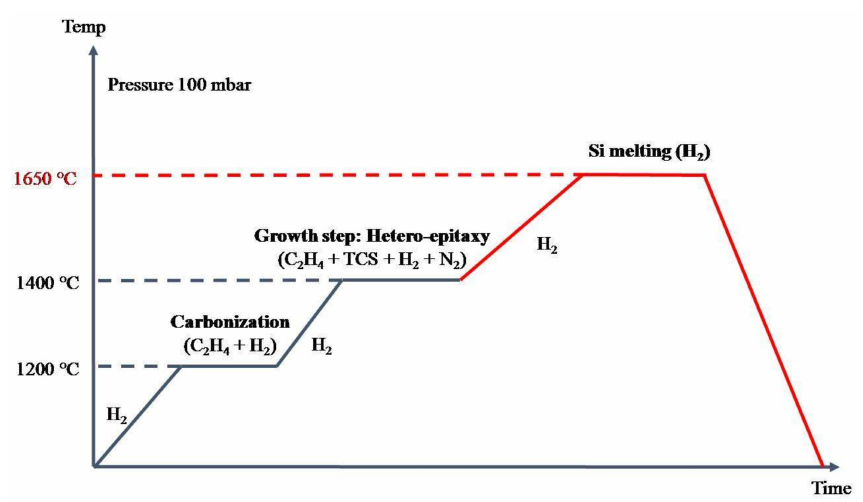
Figure 1. Scheme of the synthesis process of free-standing 4 and 6 inch wafers of 3C-SiC [12].